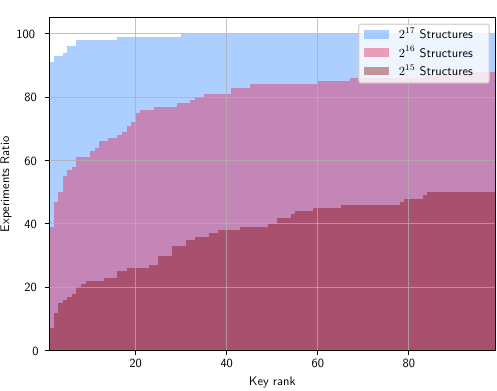
Figure 6: Rank distribution for the correct key among 2 16 candidates from 100 runs of our six-round attack with Small- AES , with random keys and 2 15 , 2 16 , or 2 17 structures of 2 16 texts